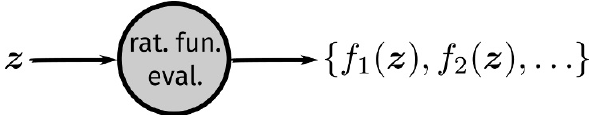
Figure 2 . A node representing the evaluation of a list of rational functions. It takes one list z as input, interpreted as the list of arguments of the functions, and returns the values of the functions evaluated at z